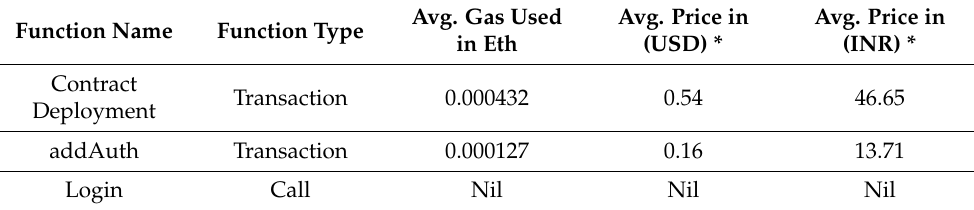
Table 3. Smart Contract transaction types and gas details.